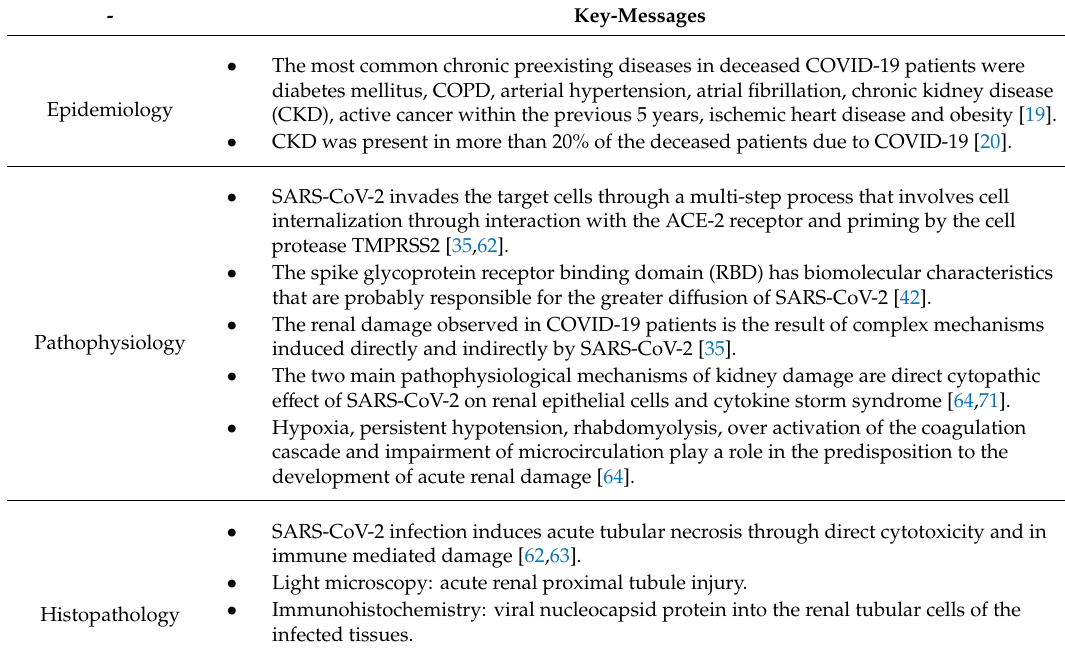
Table 1. Summary of the main evidence emerging from the